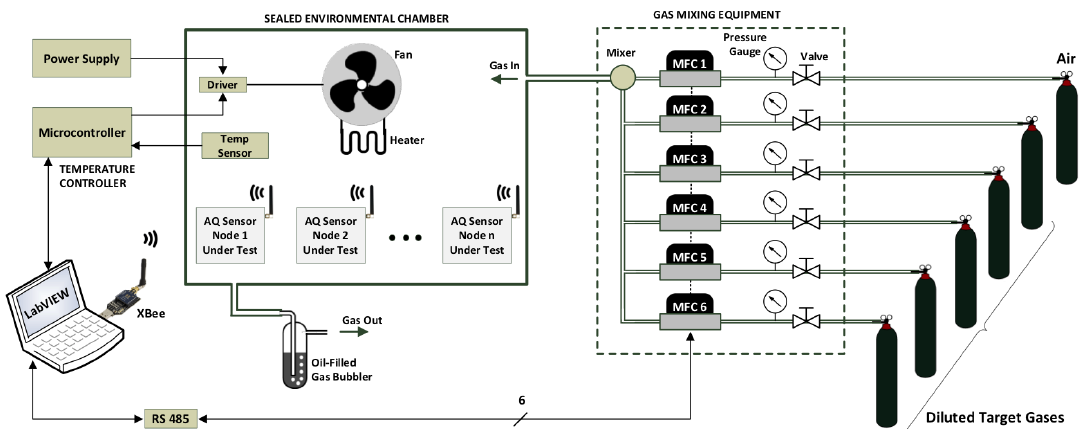
Figure 2. Architecture of the proposed calibration setup.